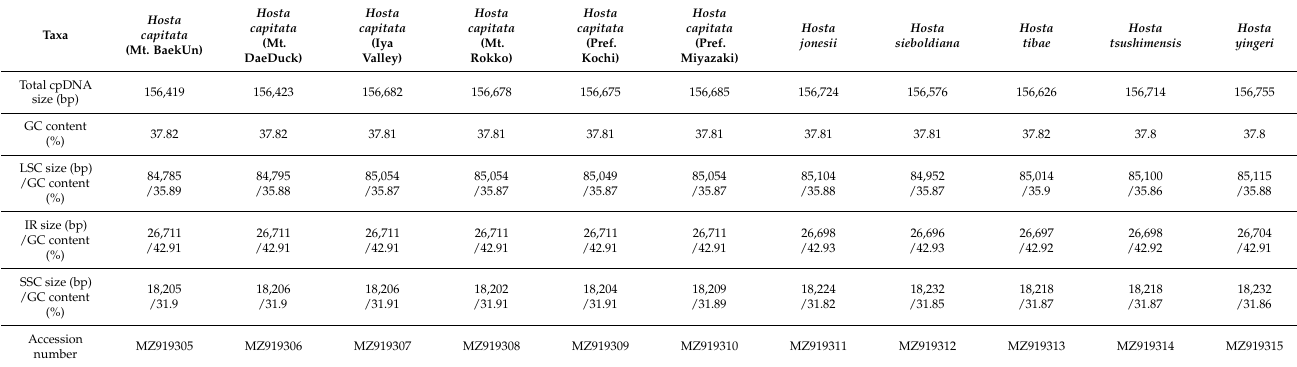
Table 1. Summary of the characteristics of the 11 Hosta chloroplast